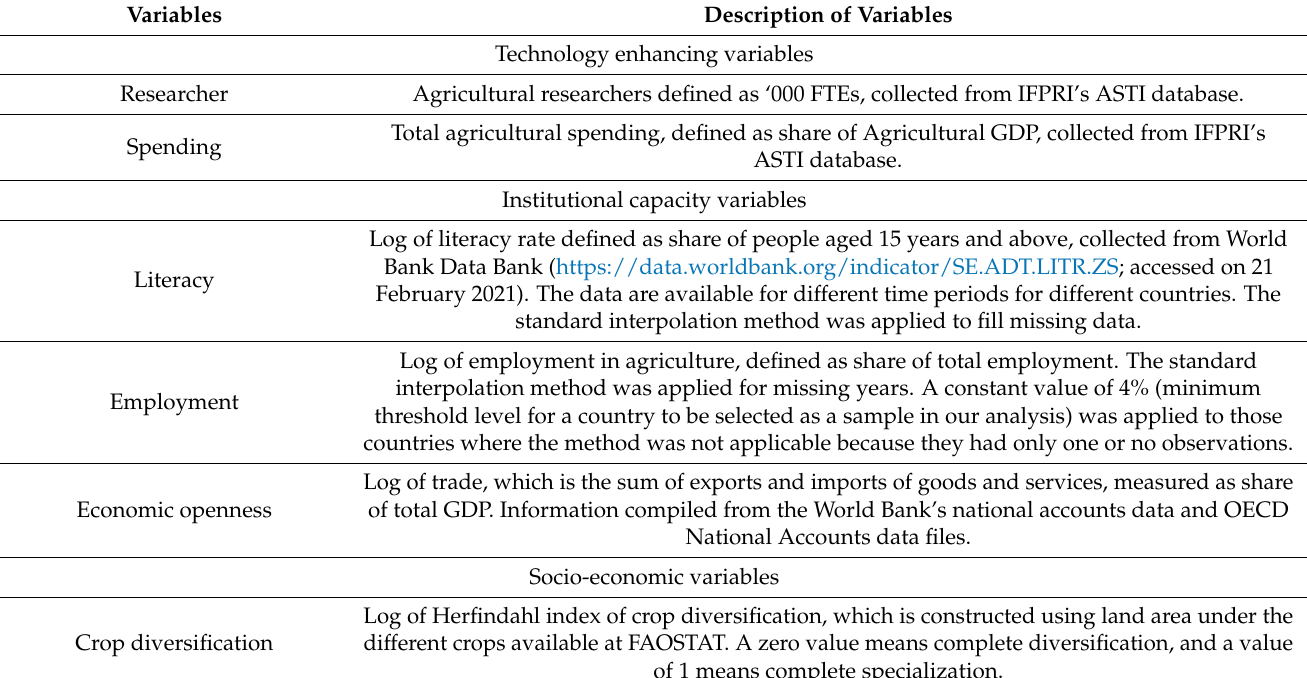
Table 1. Definition and construction of the